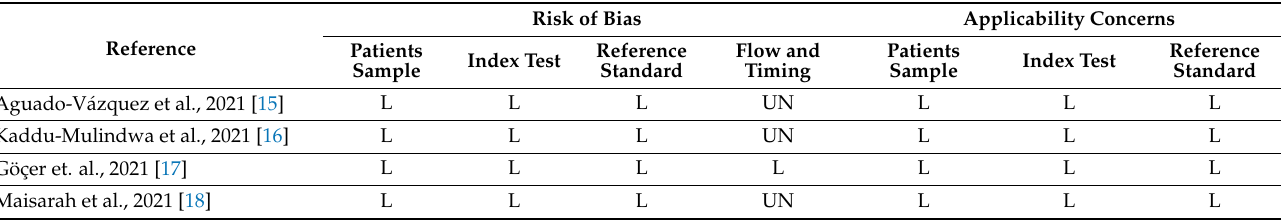
Table 4. Quality assessment of the included